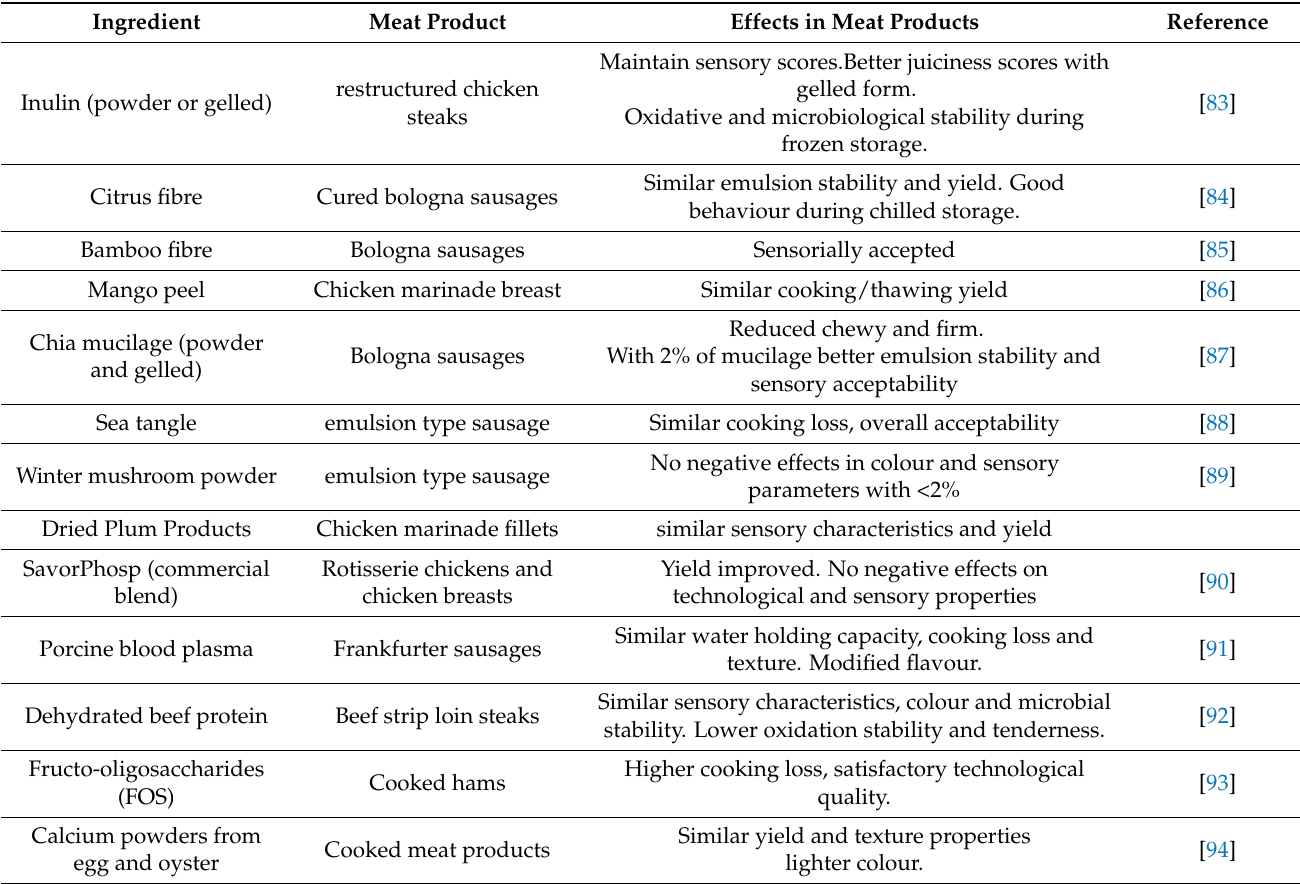
Table 3. Ingredients used as phosphates alternatives in the development of clean-label meat